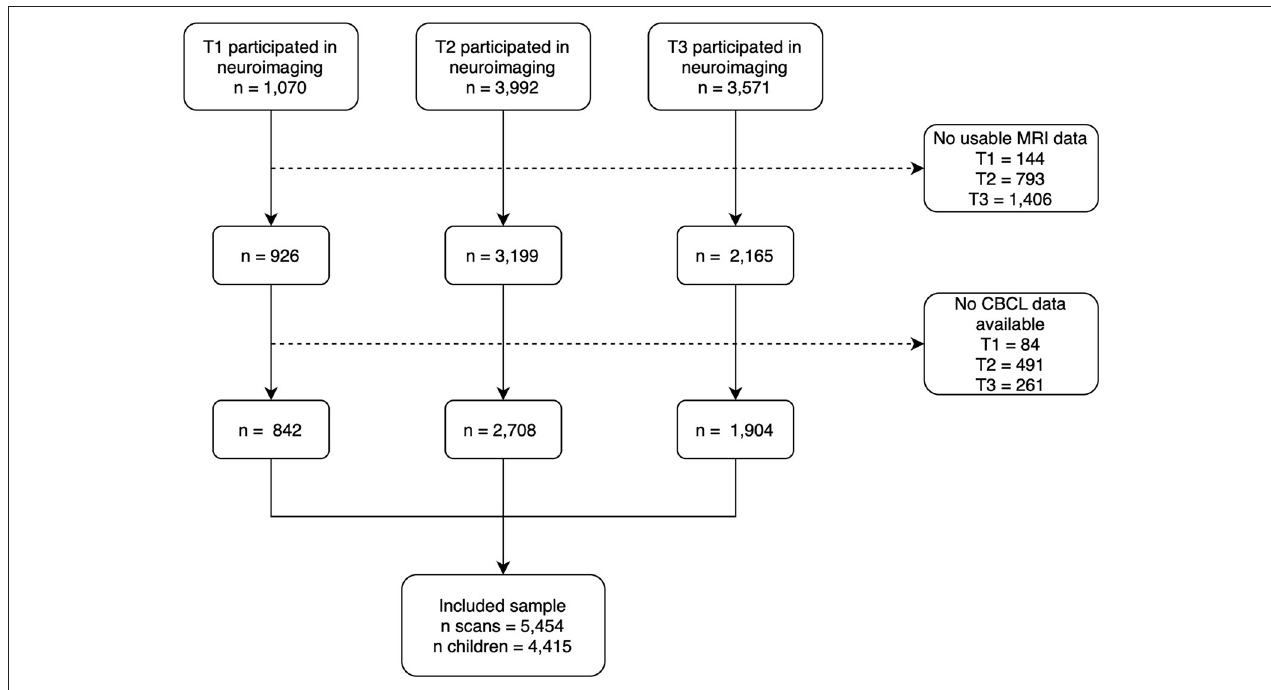
FIGURE 1 | Flowchart of the study